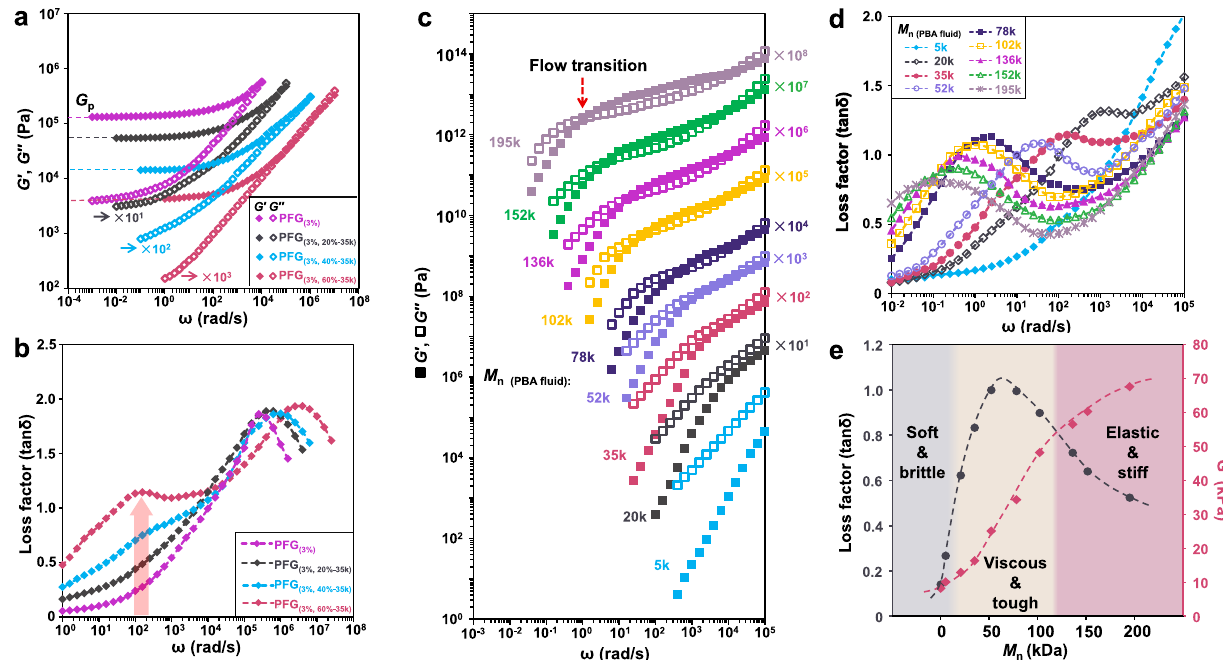
Fig. 3 Dynamic mechanical master curves of polymer- fl uid-gels (PFGs). a , b Frequency dependence of storage modulus ( G ′ ), loss modulus ( G ″ ), and loss factor (tan δ ) for PFGs. The master curves were obtained by time-temperature superposition (TTS) and shifted horizontally by the indicating factors for clarity. Plateau modulus ( G p ) of the PFGs reduces with increasing poly (n-butyl acrylate) (PBA) fl uid content. In the high-elastic region of the bulk network, a de fi nite peak of tan δ becomes more obvious as Φ PBA fl uid increases, indicating that the peak originates from the whole chain reptation of PBA fl uid. c Vertically shifted modulus master curves of PBA fl uids with varying M n (PBA fl uid) . Filled squares: G ′ , open squares: G ′′ . d Master curves for the tan δ of PFGs with Φ c = 3%, Φ PBA fl uid = 60%, and varying M n (PBA fl uid) . As M n of polymer fl uids increases, the de fi nite peak of tan δ shifts to the lower frequency side. e Tan δ and G ′ of PFGs with Φ c = 3% and Φ polymer fl uid = 60% as a function of M n (PBA fl uid) at a frequency of 10 rad s − 1 and T = 25 °C. M n (PBA fl uid) : molecular weight of PBA fl uids, Φ c : weight fraction of cross-linker, Φ polymer fl uid : weight fraction of PBA fl